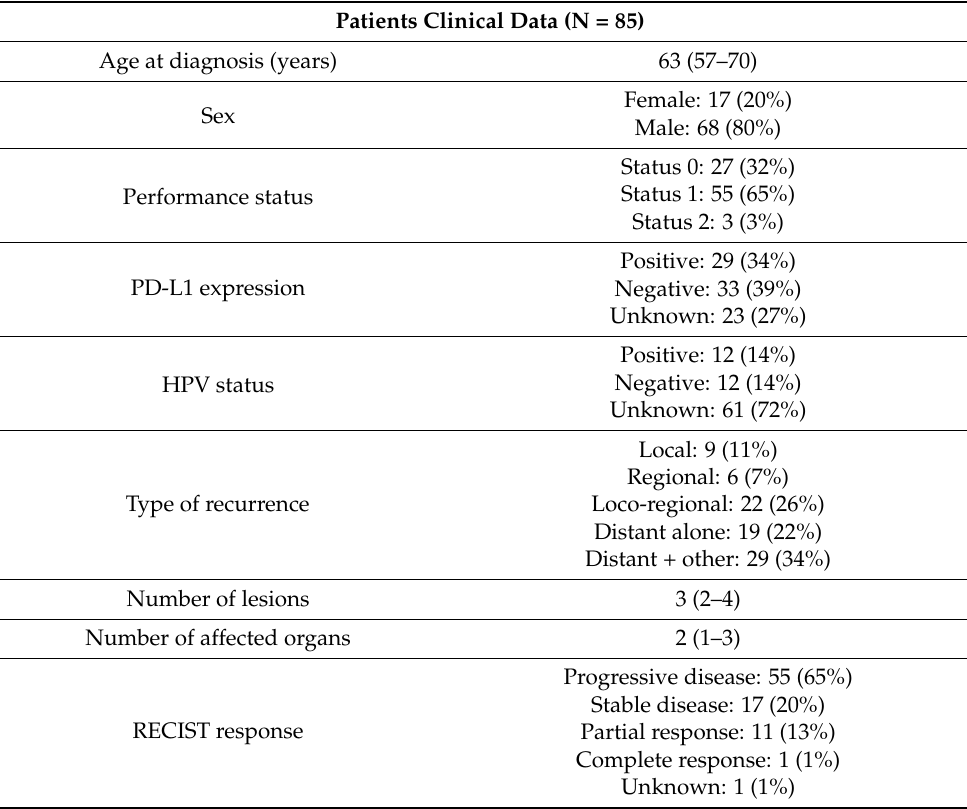
Table 1. Clinical data of patients involved in the study and best response to treatment. Numerical variables are expressed as median and inter-quartile